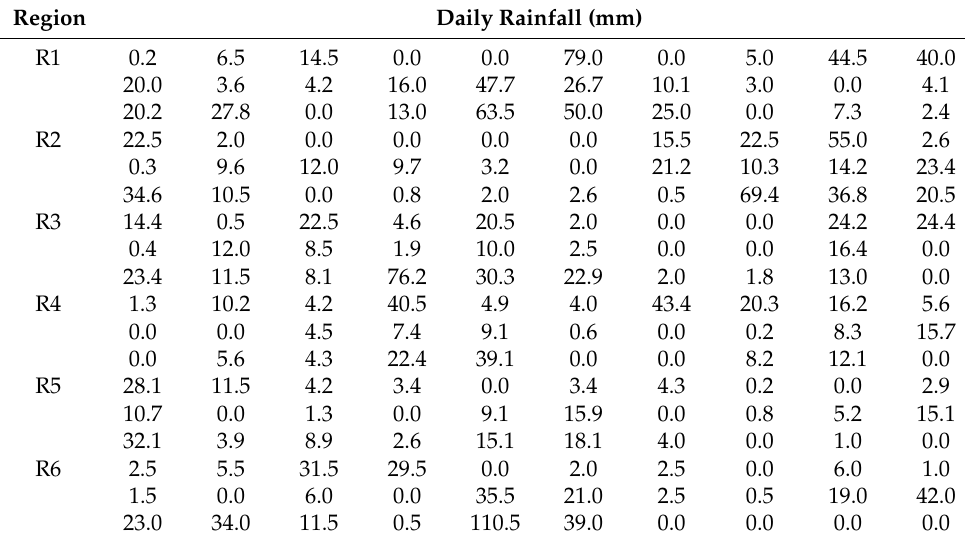
Table 5. The daily rainfall data for September 2021 in Thailand by region.